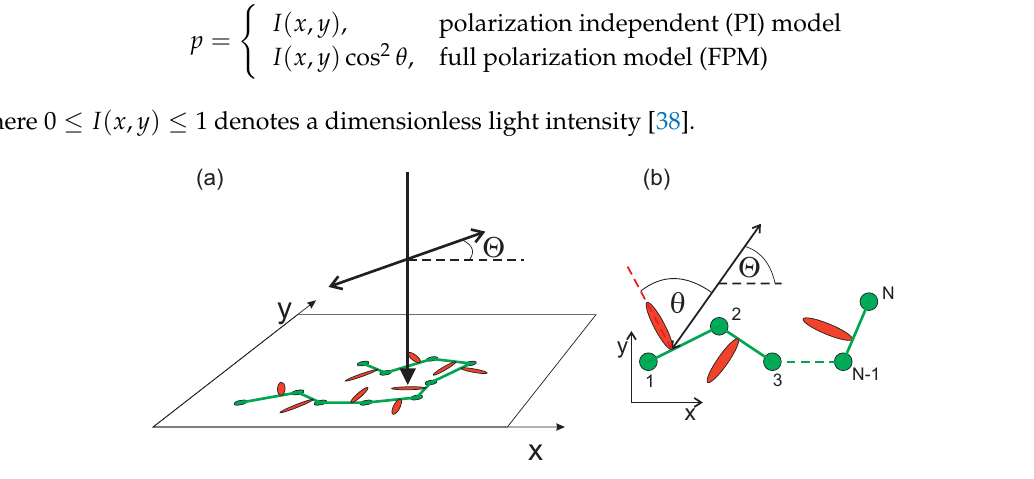
Figure 2. Geometry of the 2D azo-dye system ( a ). Polymer chains lie in x − y plane, light polarized in x − y -plane propagates along the z -direction ( b